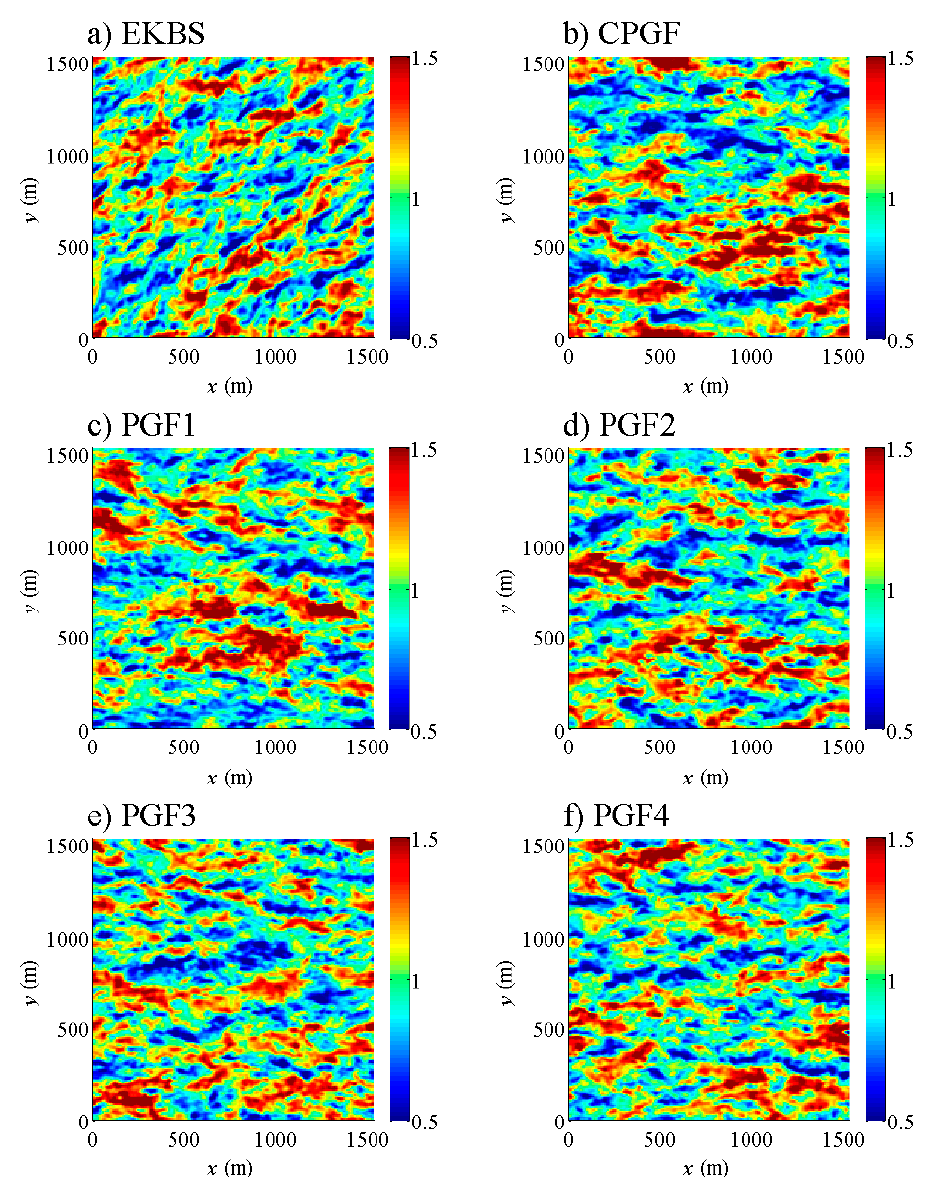
Figure 7. Instantaneous horizontal wind velocities on a horizontal plane at z = 56 m and t = 10,800 s for the boundary-layer simulations (1568 m × 1568 m × 800 m): ( a ) EKBS; ( b ) CPGF; ( c ) PGF1; ( d ) PGF2; ( e ) PGF3; ( f ) PGF4. For each simulation, wind velocities are normalized by the mean wind velocity at z = 56 m.